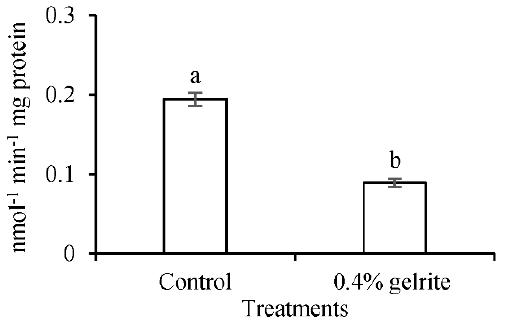
Figure 11. PAL activity of 14 days old Arabidopsis thaliana Col-0 leaves on 0.7% ( w / v ) Micro-agar (control) and 0.4% ( w / v ) gelrite medium. a and b letters indicate significant differences between means at α = 0.05 level.